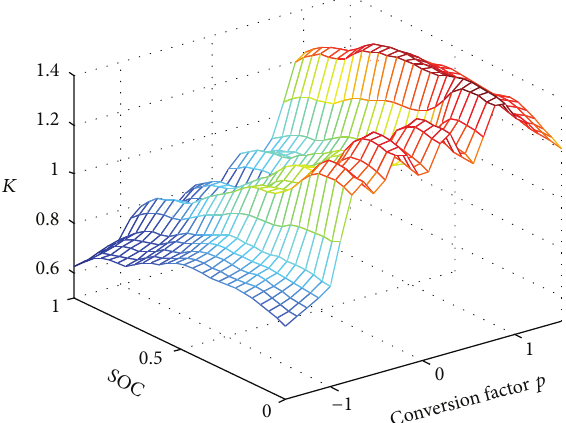
Figure 7: Output result of cloud controller.